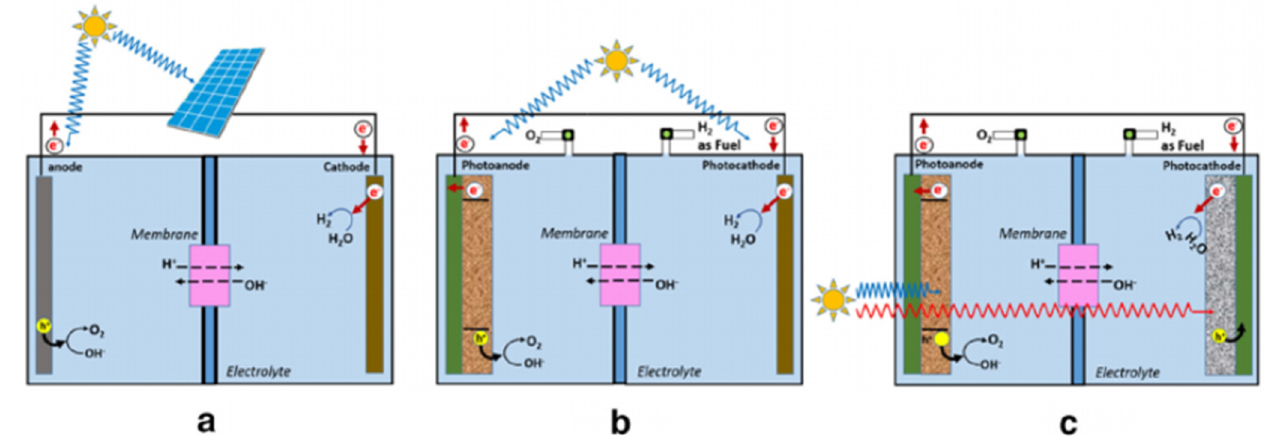
Figure 14. Scheme of photoelectrochemical (PEC) system: ( a ) a photoelectrode PEC system supplied by PV cell, ( b ) two-photoelectrode PEC system in parallel, and ( c ) a two-photoelectrode PEC system in series.